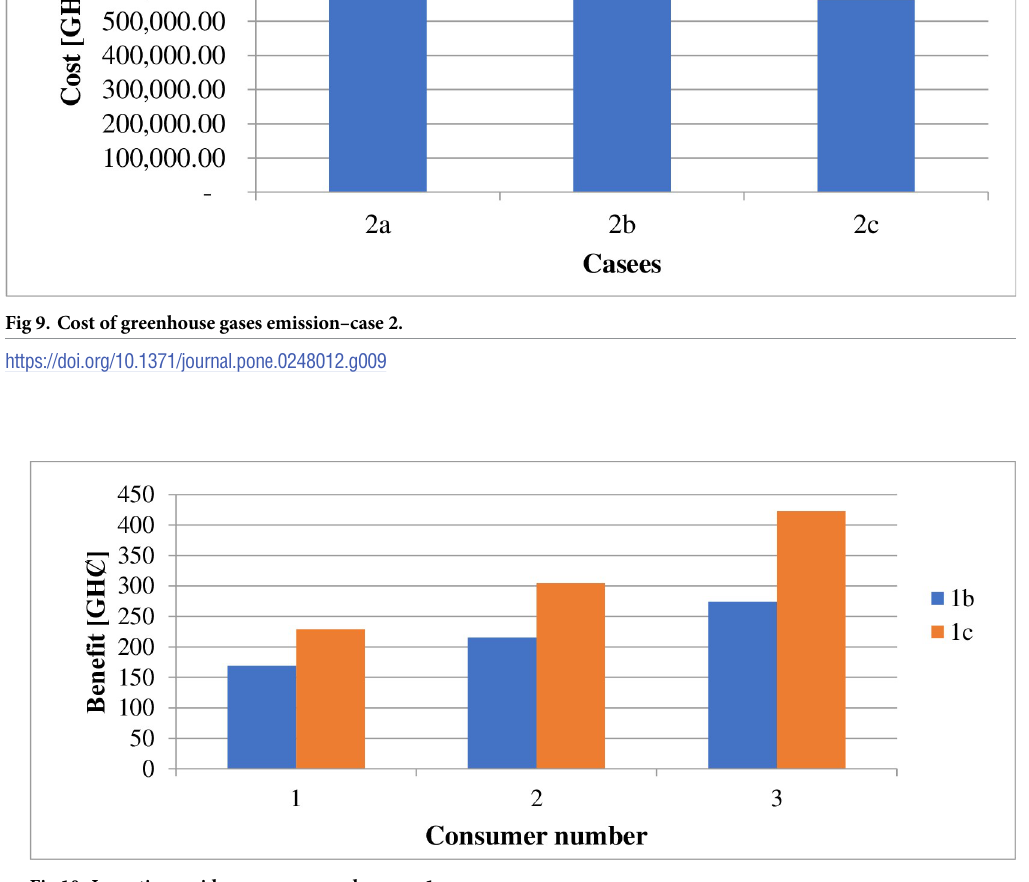
Fig 10. Incentives paid consumers per day–case